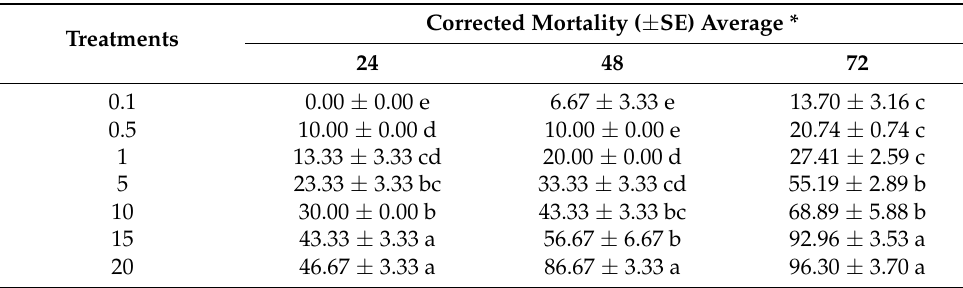
Table 2. Effect of Moringa oleifera leaf ethanolic extract at different concentrations on Tetranychus merganser females under controlled laboratory conditions ( n = 3 with 10 red spider mites per replicate).